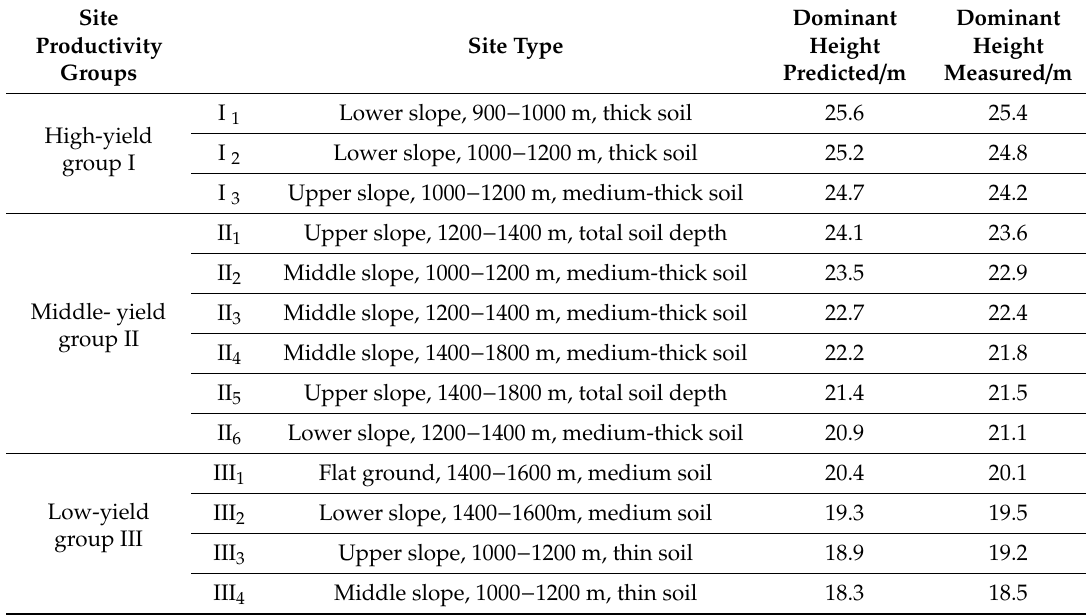
Table 5. Site evaluation of E. urophylla × E. grandis plantation in southern Yunnan.